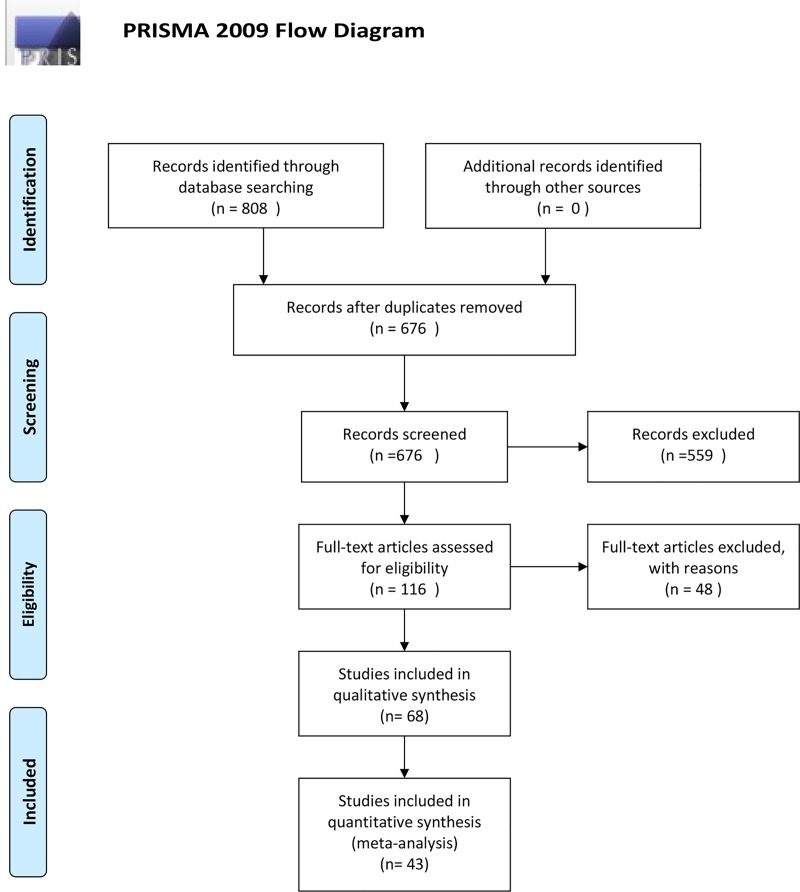
Flowchart of identification of eligible studies.